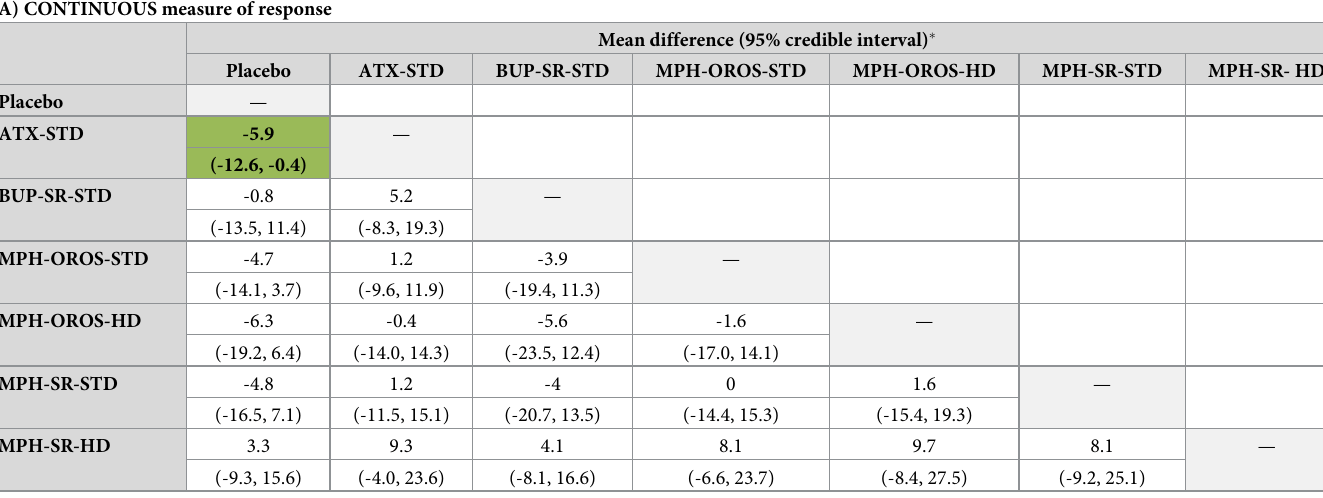
Fig 4. Network diagrams for patient-reported clinical response. Treatment nodes are proportional to the number of patients who took the corresponding treatment, while the width of each edge is proportional to the number of trials included in the comparison. Intervention abbreviations: ATX = atomoxetine, BUP-SR = sustained release bupropion, HD = high dose, MPH = methylphenidate, OROS = osmotic-release oral system, STD = standard dose, SMD = standardized mean difference, SR = sustained release. (A) Continuous measure of response. (B) Dichotomous (treatment response: yes versus no).